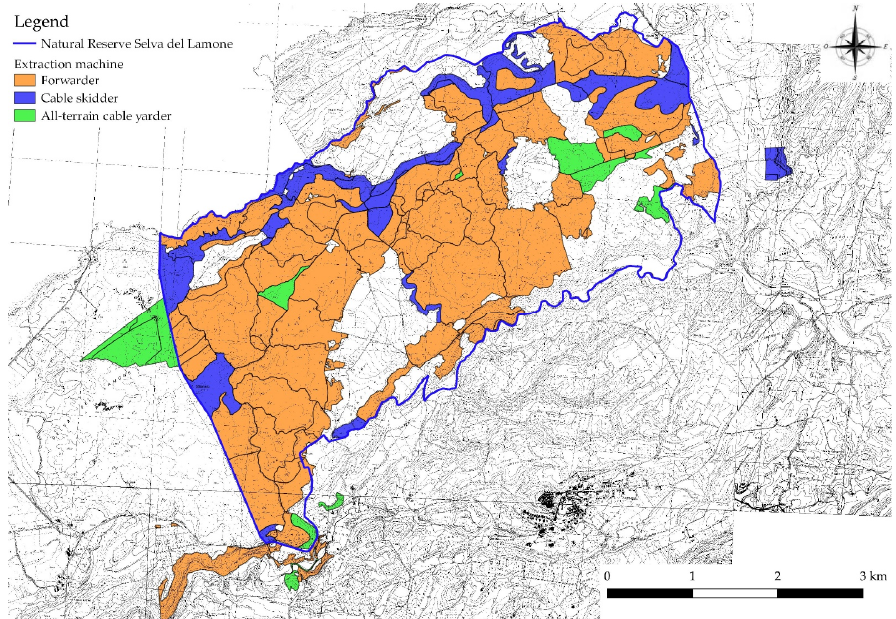
Figure 3. Extraction system suggested by the GIS-AHP procedure in all the cutting blocks of the study area. It is important to notice that there are some cutting blocks outside the boundaries of the